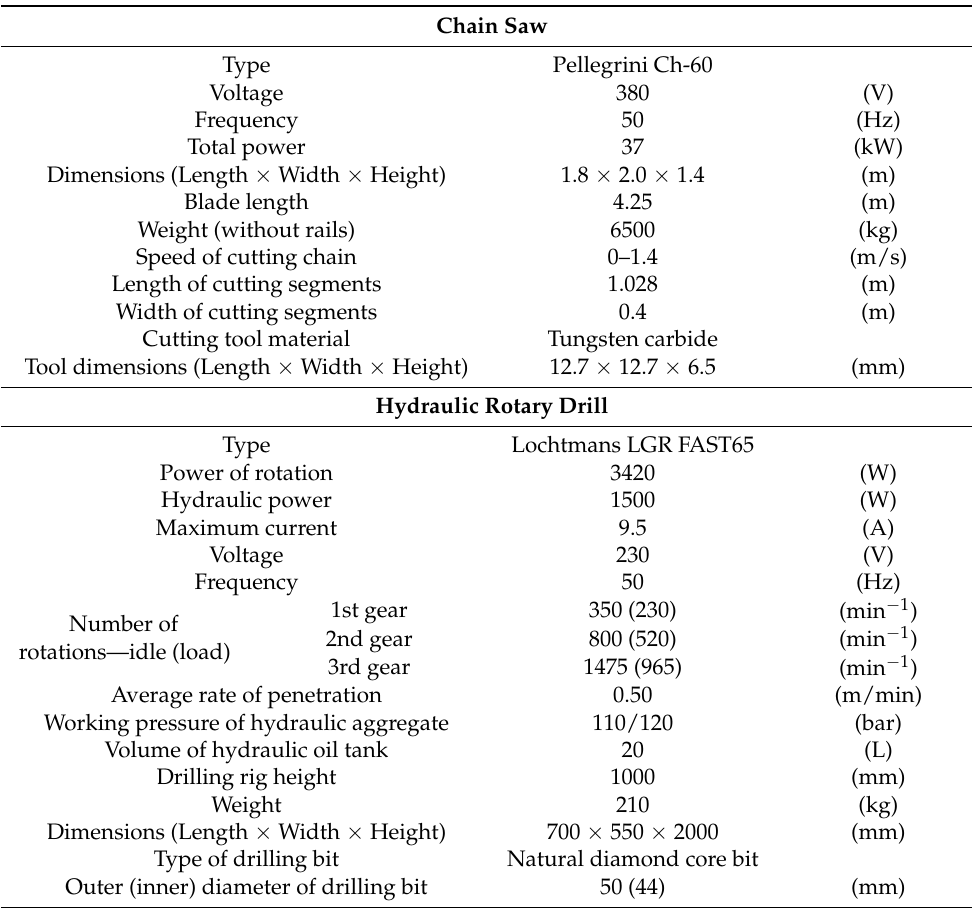
Table 3. The characteristics of a chain saw and a hydraulic rotary drill.